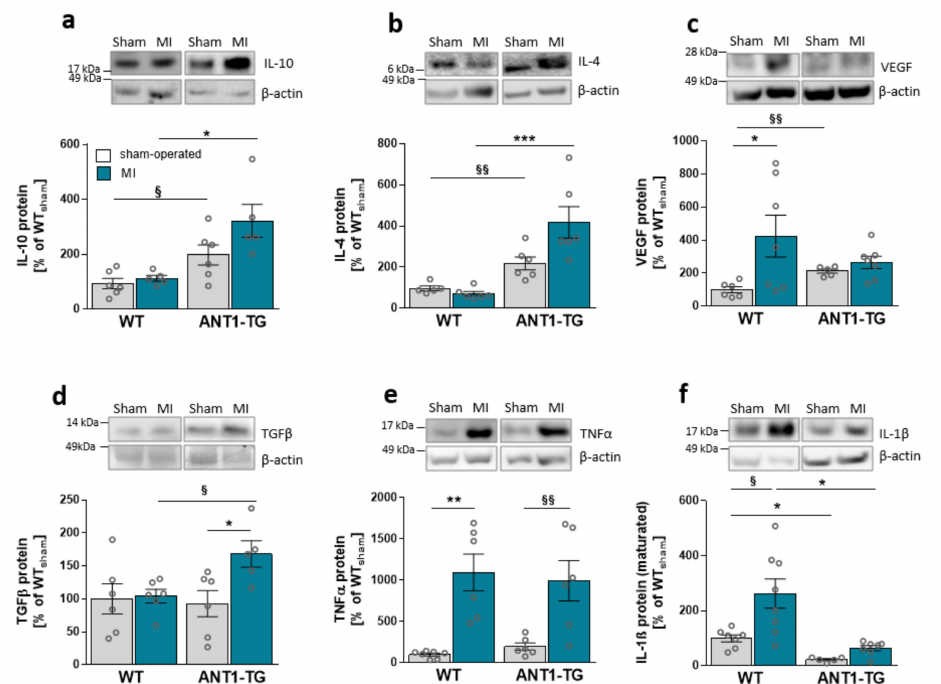
Figure 1. Cytokine expression pattern in sham-operated and infarcted myocardium derived from WT and ANT1-TG rats. Cytokine protein abundance of ( a ) IL-10, ( b ) IL-4, ( c ) VEGF-A, ( d ) TGF β , ( e ) TNF α , and ( f ) IL-1 β in sham-operated and infarcted heart tissue of WT and ANT1-TG rats. The upper panel shows representative Western blots, with β -actin as the internal control. * p < 0.05; ** p ≤ 0.01, *** p ≤ 0.001 calculated with the Kruskal–Wallis test, using the Dunn’s test as post hoc test; § p < 0.05; §§ p < 0.01 calculated with Mann–Whitney U test. WT: wild-type rat; ANT1-TG: adenosine nucleotide translocase 1 transgenic rat; MI: myocardial infarction; IL: interleukin; VEGF: vascular endothelial growth factor; TGF β : transforming growth factor β ; and TNF α : tumor necrosis factor α .